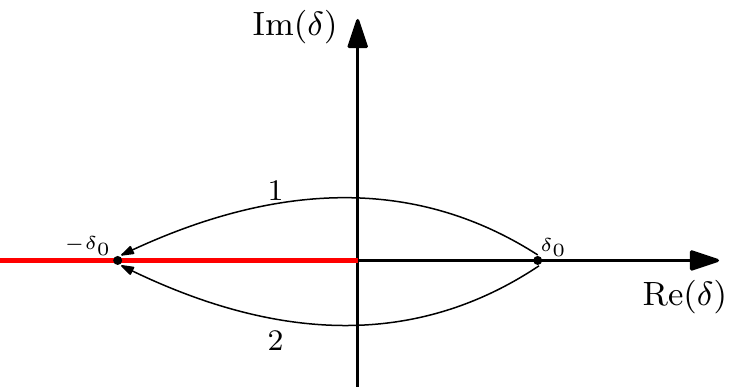
0 . However, paths 1 and 2 0 >